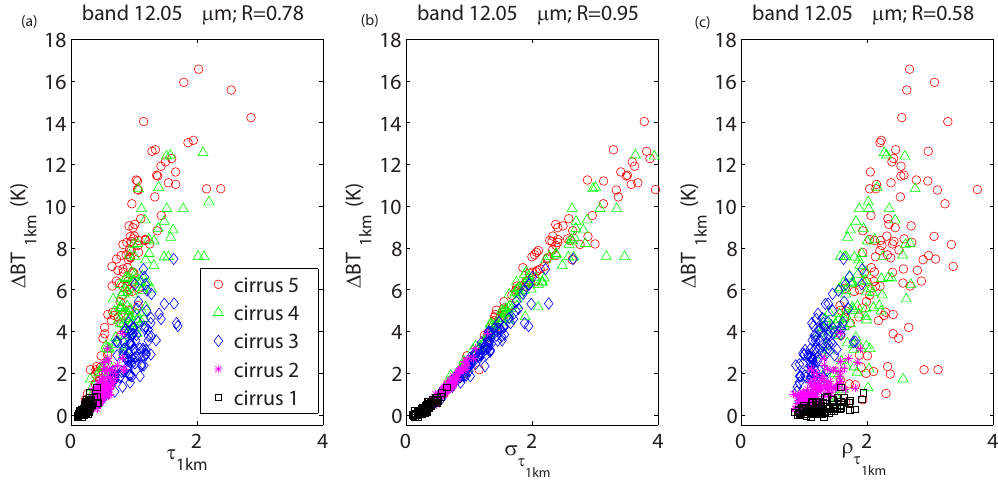
Figure 11. Brightness temperature differences, 1 BT 1km , as a function of the optical thickness τ 1km , the optical thickness standard deviation σ τ and the heterogeneity parameter ρ τ for different cirri presented Table 1 and for the band at 12 . 05µm. R represents the correlation 1km 1km coefficient computed for the five